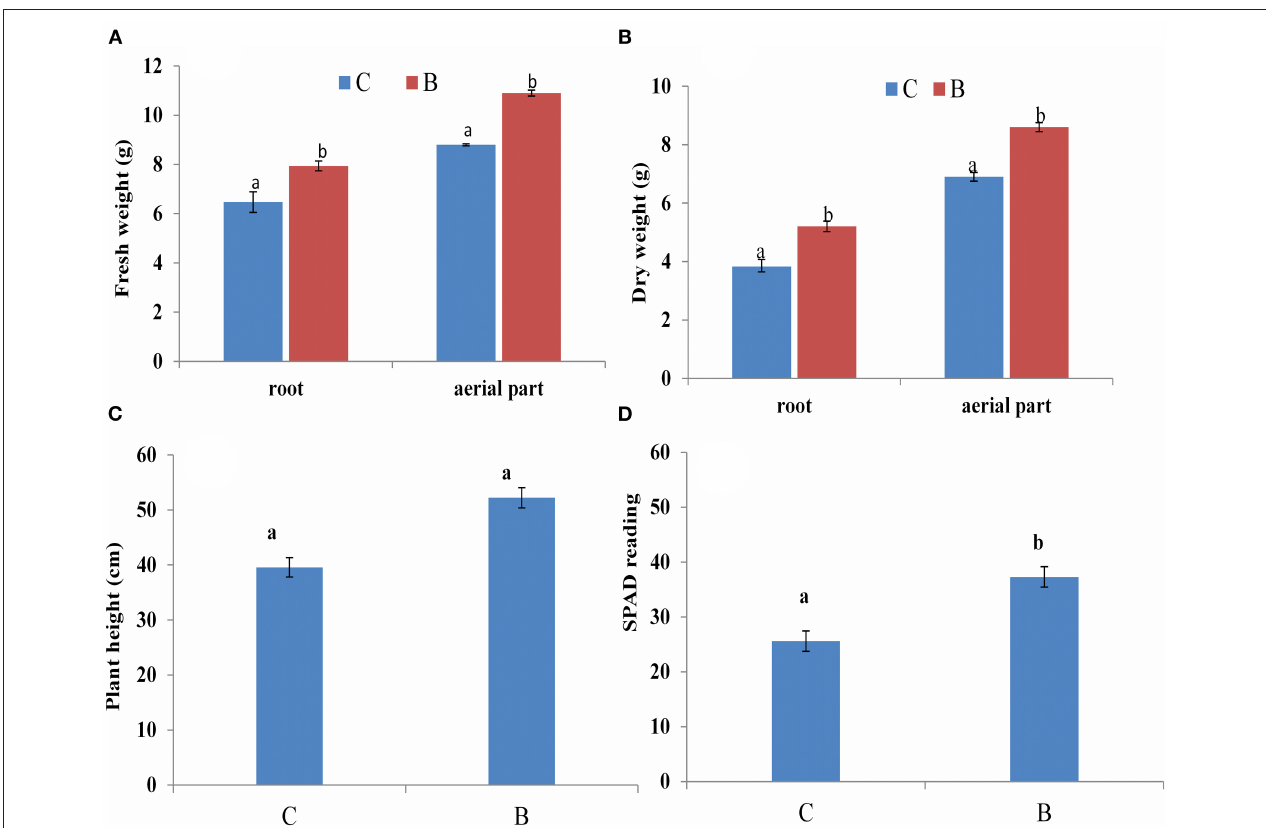
FIGURE 9 | Sugarcane plant growth at 60 days (A) Fresh weight (B) Dry weight (C) plant height, (D) Chlorophyll content (SPAD reading). C: monoculture; B: intercrop; Columns marked with different letters indicate significant differences between the means according to DMRT test, (Mean ± SD, n =